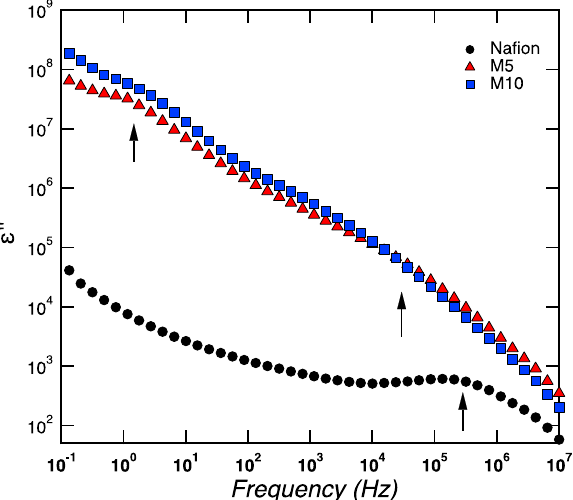
Figure 5. Frequency dependence of the imaginary part of the permittivity for Nafion, M5, and M10, at a given temperature of 20 °C, during cooling.